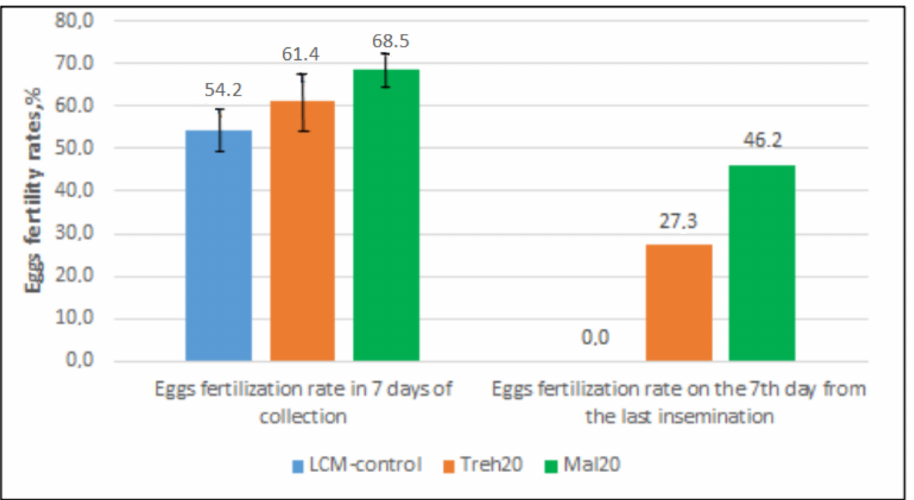
Figure 2. Fertility of eggs of hens inseminated with frozen/thawed semen using cryoprotective diluents LCM control, Treh20, and Mal20. The composition of the diluents LCM control, Mal20, and Treh20 is presented in Table